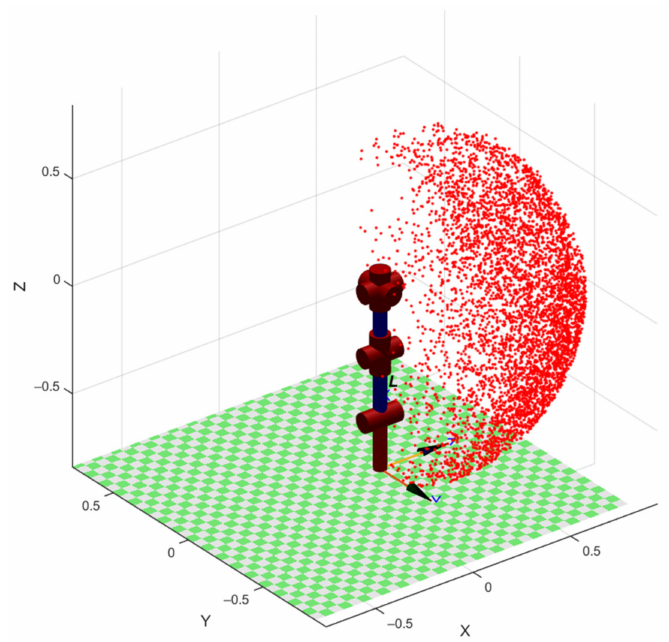
Figure 7. The solution of the forward kinematics problem for 30,000 random positions. When solving the DKP, two coordinate systems are considered: the initial one, associ- ated with the base joint x 0 , y 0 , z 0 , and the final one, associated with the end-effector of the manipulator x n , y n , z n